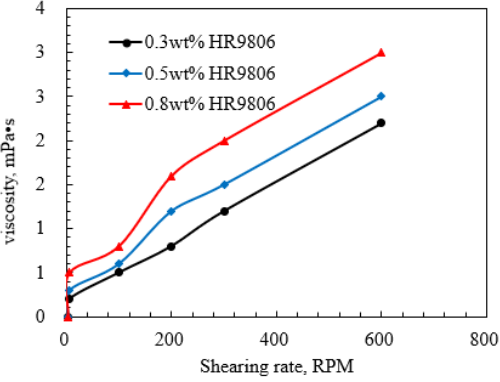
Figure 5. Base fluid viscosity of HR9806 with simulated formation water.